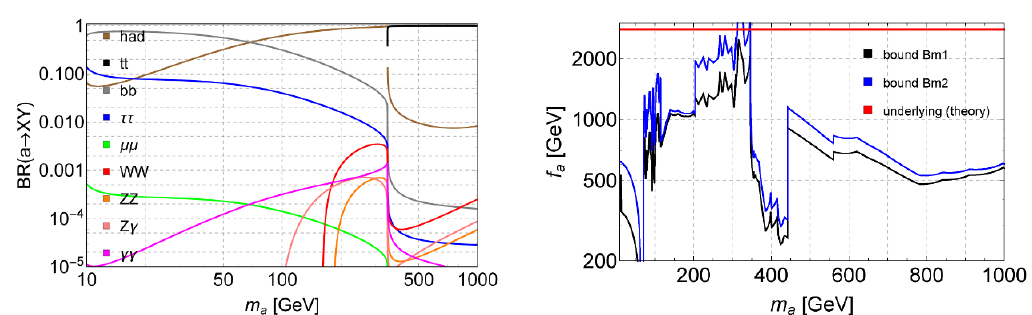
Figure 2 . Left: branching ratios of a as a function of the mass m a in the benchmark model Bm1 characterised by the parameters in eq. (2.6). Right: experimental lower bounds on f a from ATLAS and CMS resonance searches on the benchmark models Bm1 (blue) and Bm2 (black) as compared to the underlying theory value